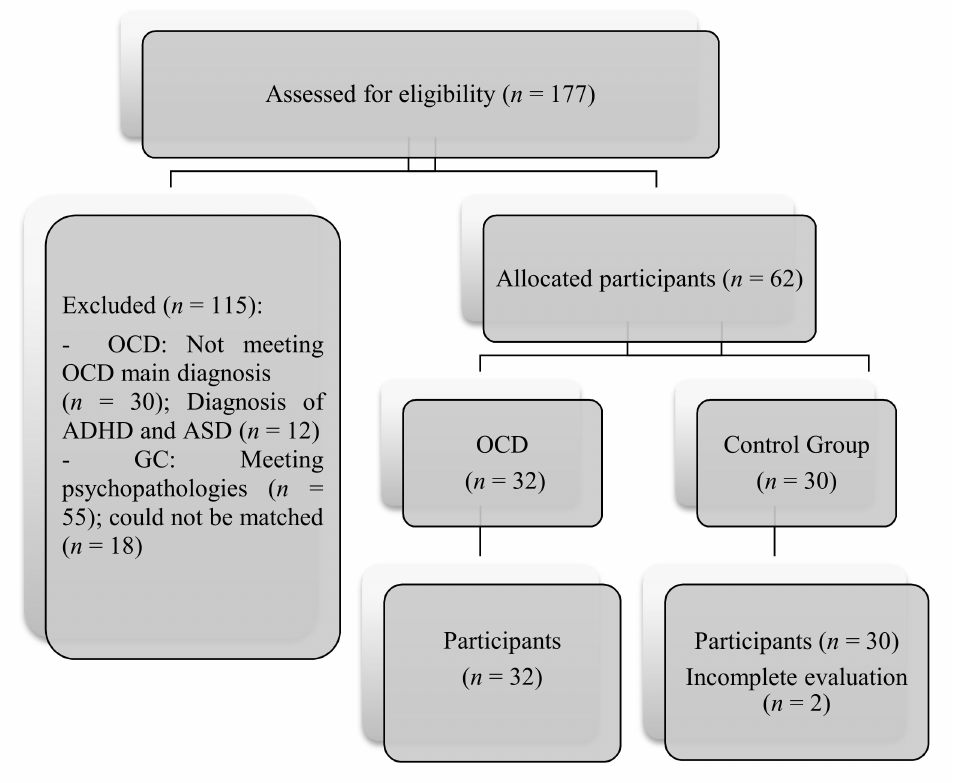
Figure 1. CONSORT flow diagrams of study